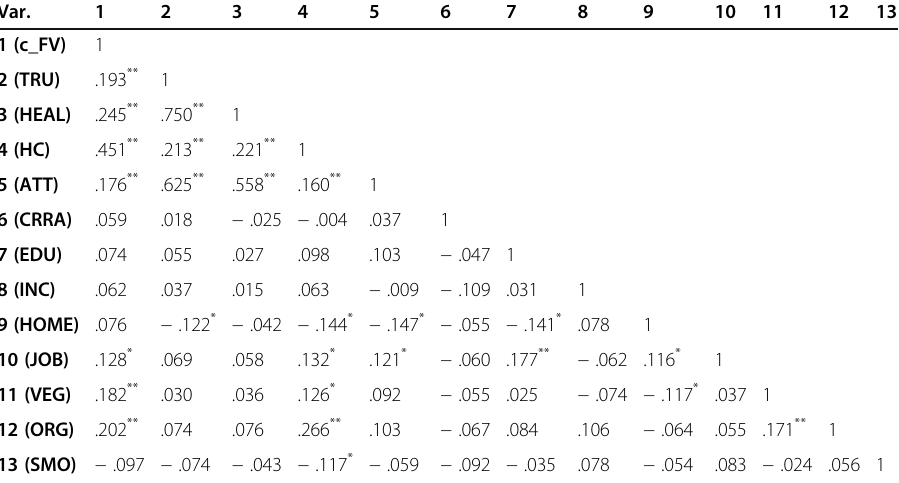
Table 5 Pearson correlations between variables